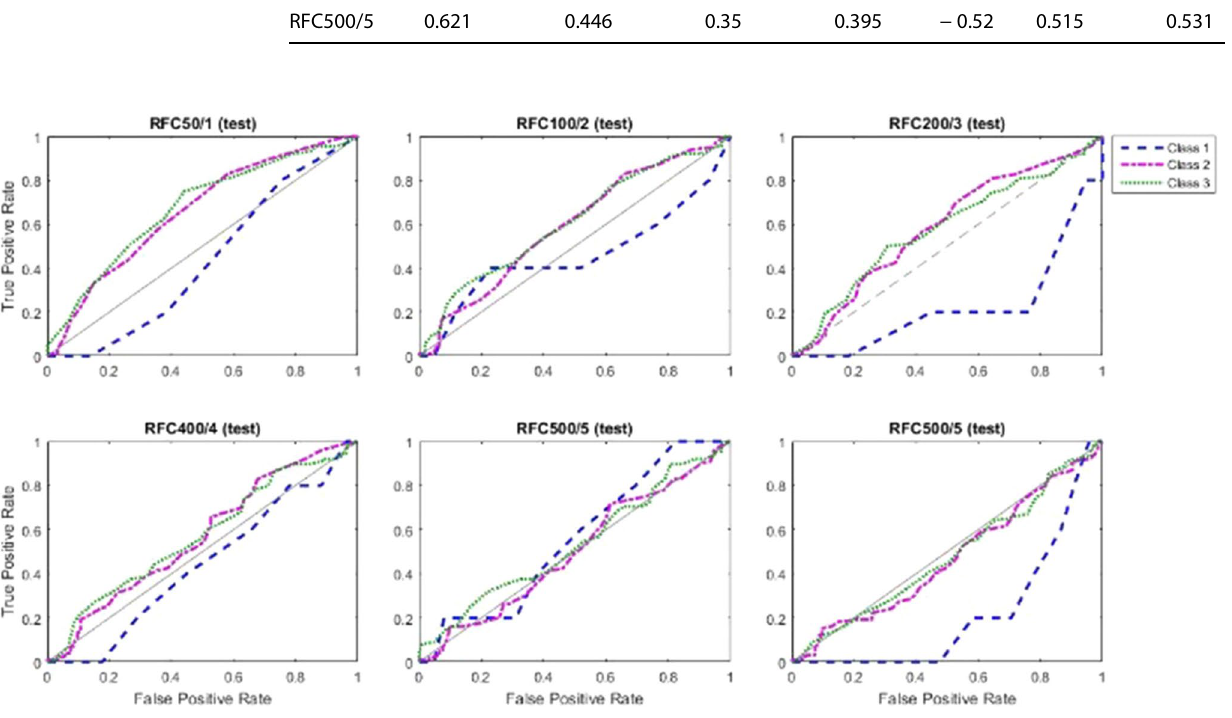
Fig. 8 ROC curve (testing) for RFC